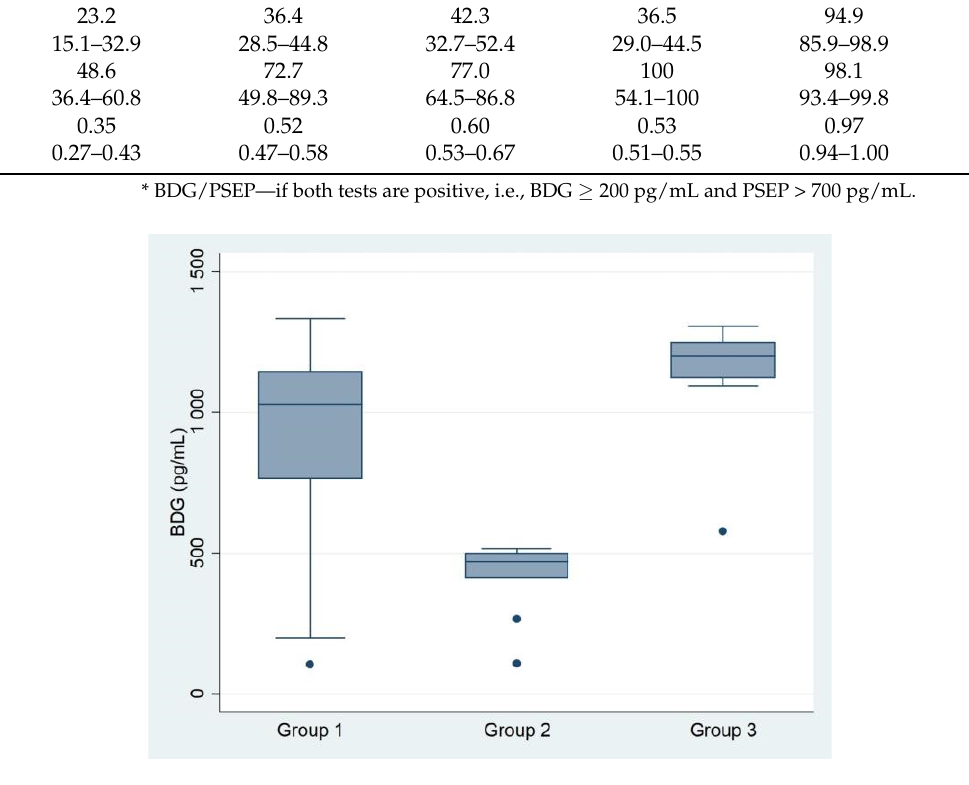
Figure 2. Serum BDG concentrations in three patient groups with candidemia confirmed by blood cultures, differing in the timing of culture-confirmed catheter surface candidiasis. Group 1: Patients without catheter colonization (i.e., negative catheter culture on the day of IBC), indicating that invasion preceded catheterization. Median BDG concentration: 1029 pg/mL. Group 2: Candidemia detected after culture-confirmed catheter colonization (catheter-related candidiasis; catheter culture was established 1–3 days before confirmation of candidemia). Median BDG concentration: 471 pg/mL. Group 3: Catheter colonization confirmed 1–3 days after proof of candidemia by culture. Median BDG concentration: 1203